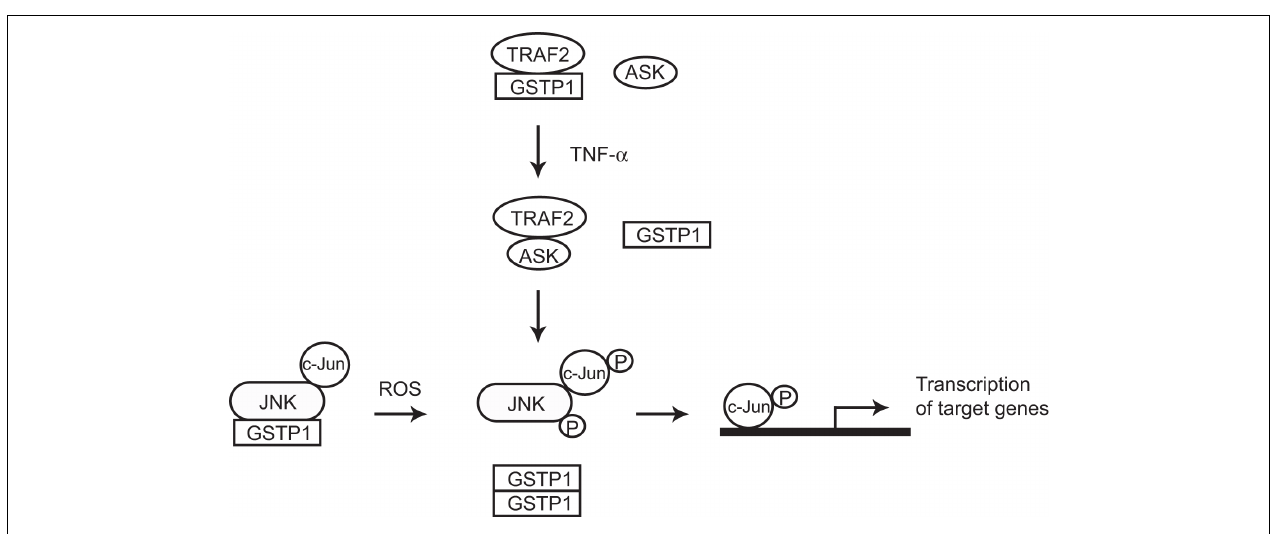
interaction competes againstTRAF2–ASK1 binding which also leads to low JNK activity. In cells exposed to ROS orTNF- α , GSTP1 dissociates from the complexes and accumulates as oligomers, with resultant activation of JNK and downstream signaling